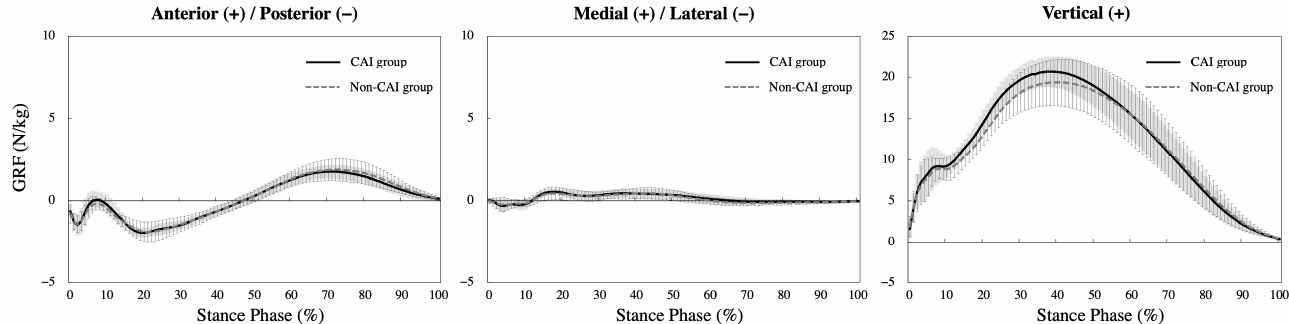
Figure 1. Time-series data of the three components of the GRF of the CAI and non-CAI groups during